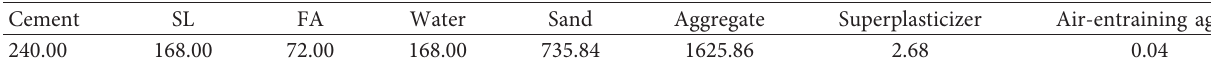
Table 2: Concrete mix proportion (kg/m 3 ).